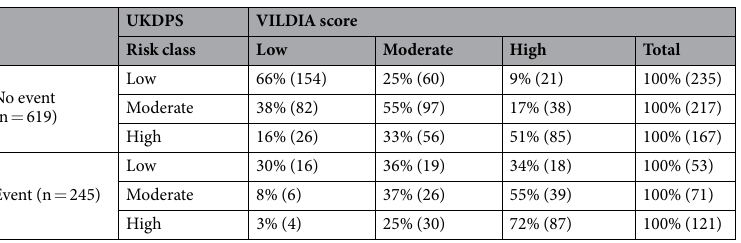
Table 3. Reclassification table. Reclassification table comparing the VILDIA score with the UKPDS score for cardiovascular mortality. Data are given as % row (n).